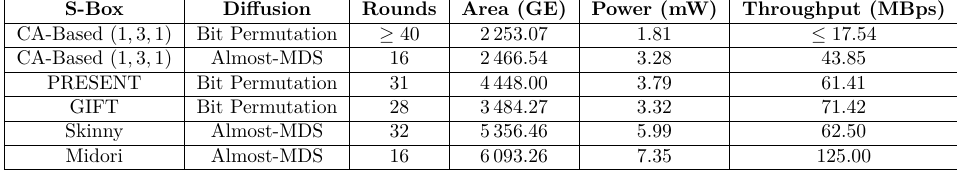
Table 7: Area, Power, and Throughput Comparison for TI of SPN block cipher across different choices of S-Boxes and design paradigms (ASIC Technology: 180nm).For through- put calculation, we have used the following: (i) the number of clock cycles required for CA-based S-Box is 8, where as for all the other S-Boxes it is 2; (ii) the critical operating frequencies for CA-based S-Box and the PRESENT S-Box are 526 . 2 MHz and 476 MHz, respectively; all other S-Boxes have critical operating frequencies close to 500